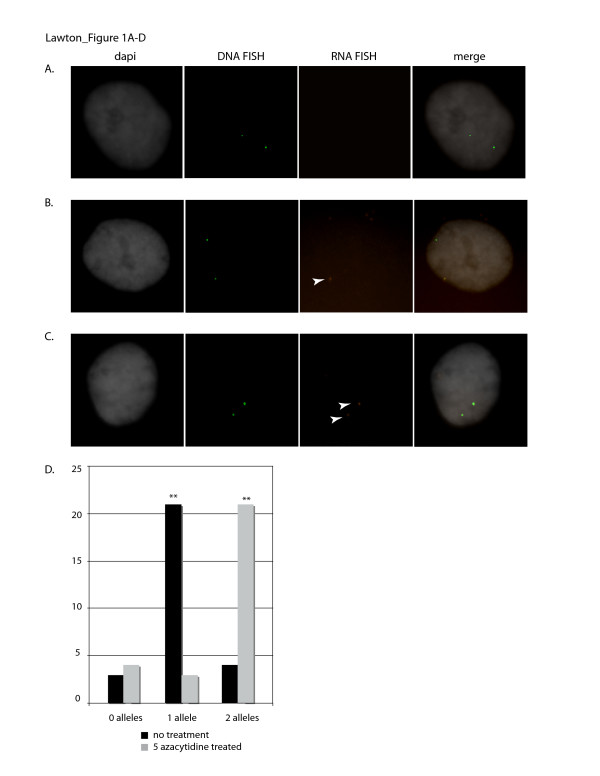
Biallelic expression of IGF2 in M. domestica is dependent on CpG methylation. A-C) RNA fluorescence in situ hybridization (FISH) detecting nascent transcripts of IGF2 (red) and DNA FISH detecting DNA copies of IGF2 (green) to interphase cells (counterstained with dapi, black and white). Individual probe images for dapi, DNA FISH, RNA FISH and the merge image are shown from left to right. A) FISH on control (no treatment) cells showing no IGF2 expression. B) FISH on control (no treatment) cells showing monoallelic IGF2 expression (RNA transcript is indicated with an arrowhead). C) FISH on 5-azacytidine treated cells showing biallelic expression (RNA transcripts are indicated with an arrowhead). D) Total cell counts/well of 0, 1 or 2 RNA FISH signals in experiment and control micrographs as designated.